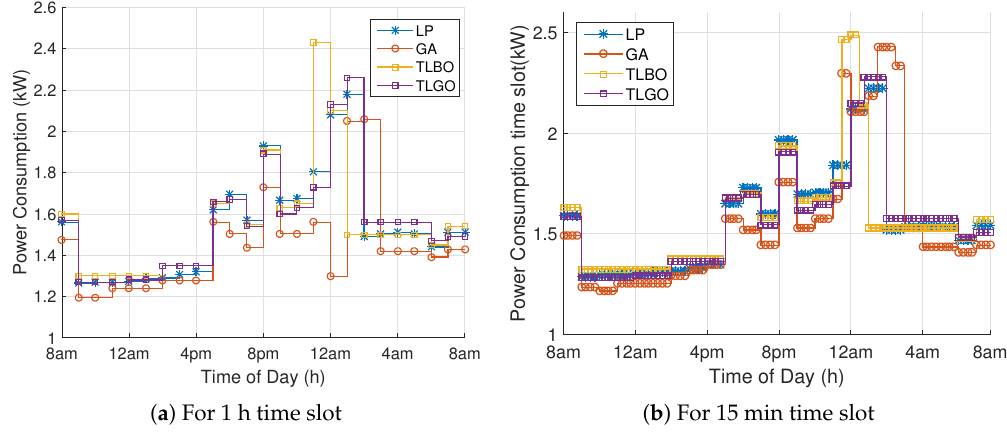
Figure 4. Power consumption of appliances under